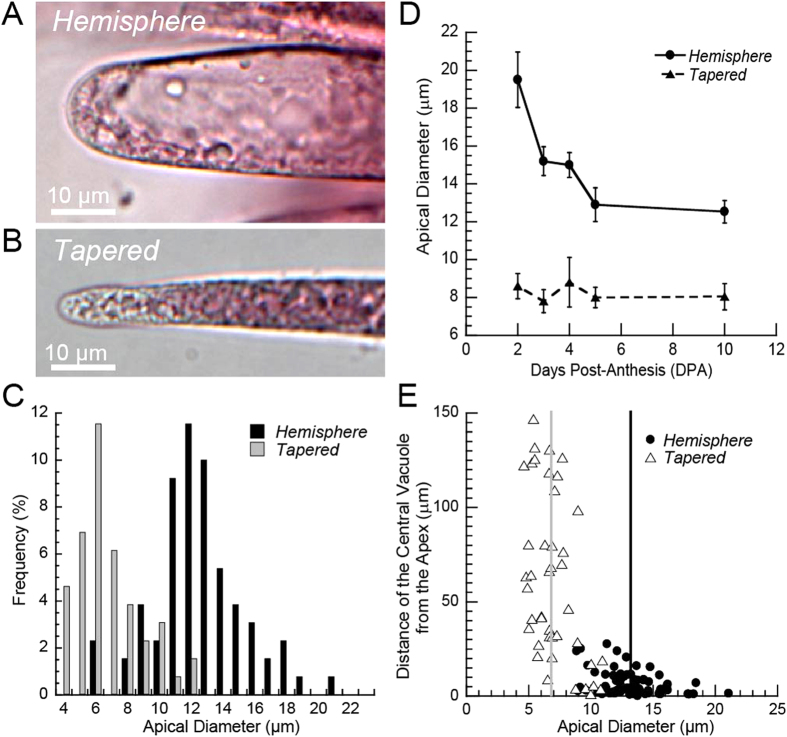
G. hirsutum fibers exhibit two tip types during early elongation based on morphology, apical diameter, and central vacuole position.(A,B) Hemisphere and tapered tip morphologies visualized in brightfield microscopy after staining with Ruthenium Red. (C) Measurement of apical diameter (at 10 μm from the apex), along with classification of tip shape as hemisphere or tapered, revealed two partially overlapping, normally distributed, subpopulations of fiber tips (n = 130). (D) Fiber tips in the hemisphere and tapered classes had different average apical diameters at 2–10 DPA (n = 77, 81, 73, 88, and 60, respectively; P < 0.0001). The apical diameter of hemisphere tips decreased after 2 DPA (P < 0.016), whereas no change occurred in tapered tips. Error bars represent 95% confidence intervals and statistical analysis was performed using ANOVA and Tukey-Kramer post-hoc test. (E) The vacuole was closer to the apex in hemisphere tips (6.86 ± 6.54 μm (s.d.); n = 69) as compared to tapered tips (60.39 ± 44.19 μm (s.d.); n = 42). The average apical diameter is shown by vertical bars for hemisphere (black) and tapered tips (grey). The difference in vacuole location between the two tip types was statistically significant (P < 0.0001, T-test). Data for (A–C,E) were collected at 5 DPA.